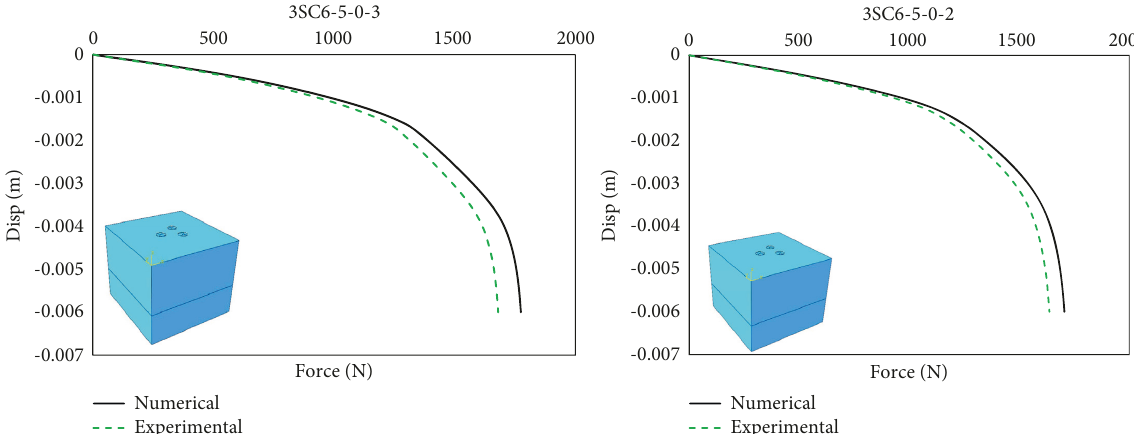
Figure 11: Force-displacement diagram related to 3SC6-5-0-2 and 3SC6-5-0-3 models in both numerical and laboratory modes.